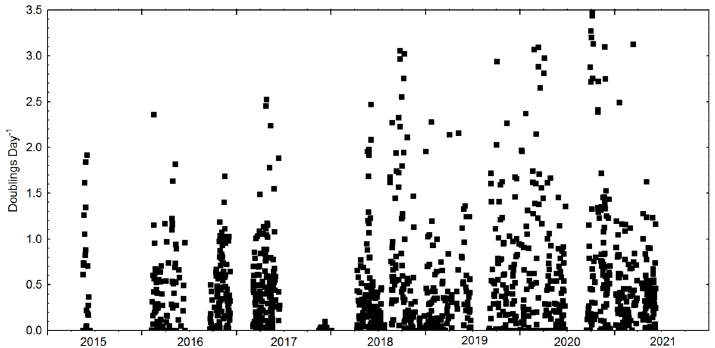
Figure 10. Cell doubling rates from all reactors for the years 2015–2021.